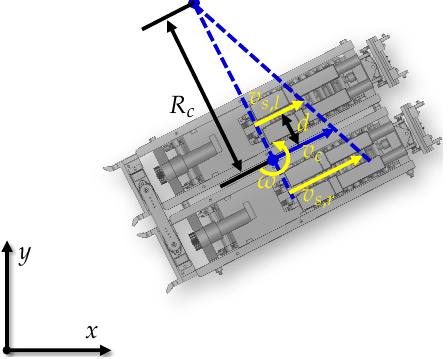
Figure 6. The rotation motion of the parallel-connected SWC